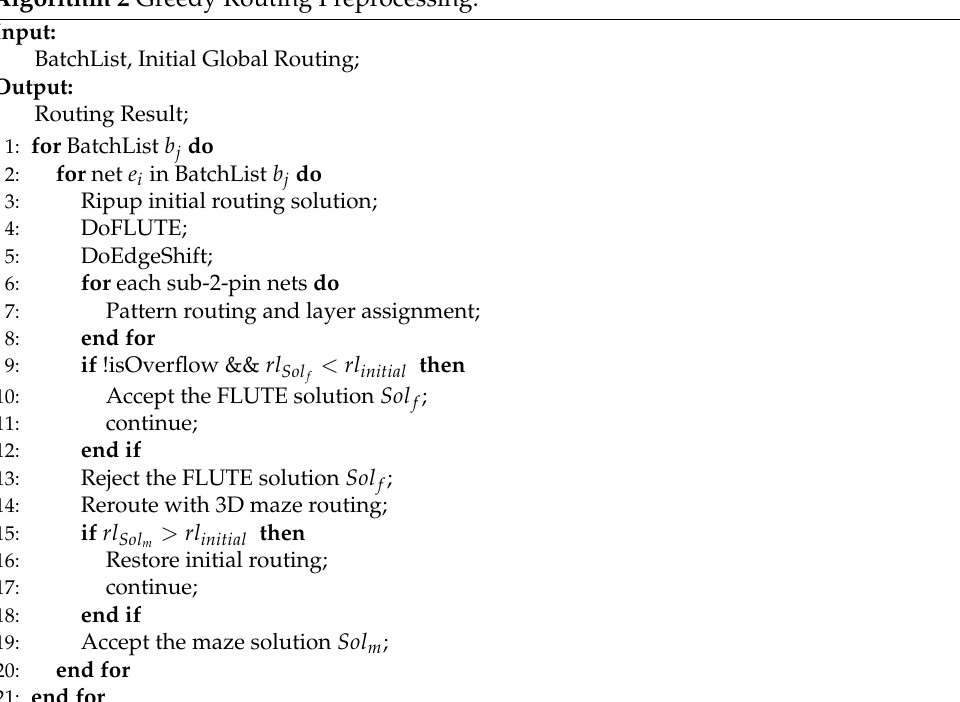
Algorithm 2 Greedy Routing